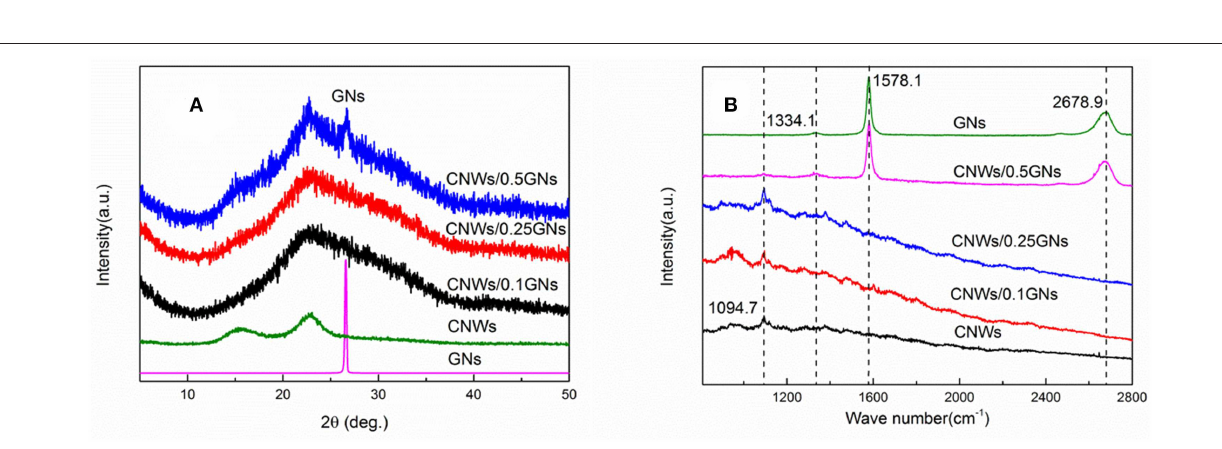
Frontiers in Materials | www.frontiersin.org